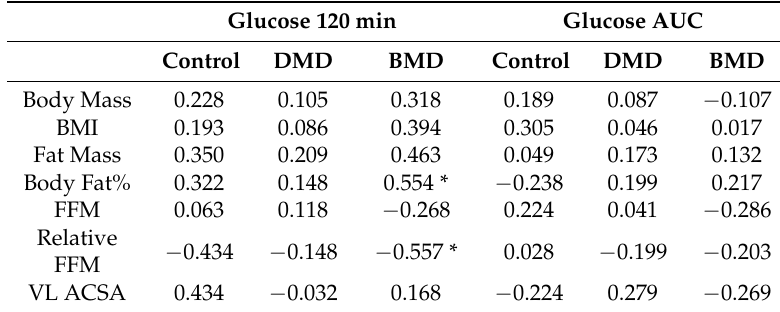
Table 2. Correlation analysis between anthropometric measurements, and markers of glucose uptake in males with (DMD and BMD) and without (Control) muscular dystrophy.